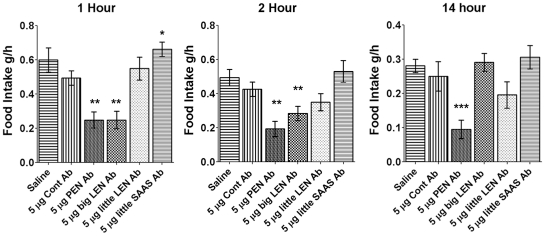
Comparison of food intake in mice injected with purified antibodies directed against proSAAS-derived peptides.Altogether, 18 mice were cannulated and in each experiment the mice were injected with either saline, control antibody (Cont Ab), or one of the antibodies directed against proSAAS-derived peptides, and food intake was measured 1 hour, 2 hours, and 14 hours after the injection. The antibody to PEN significantly reduced food intake at all time points examined. The antibody to big LEN showed a significant decrease in food intake after 1 and 2 hours, but not after 14 hours. In contrast, the antibody to little LEN did not significantly affect food intake at any time point examined, and the antibody to little SAAS showed a slight increase after 1 hour, but not at the other time points. Error bars show the standard error of the mean; saline (n = 21); control Ab (n = 19); PEN Ab (n = 8); big LEN Ab (n = 20); little LEN Ab (n = 10); little SAAS Ab (n = 8). *, p<0.05, **, p<0.01, ***, p<0.001 relative to control Ab, using Student's two-tailed t-test.